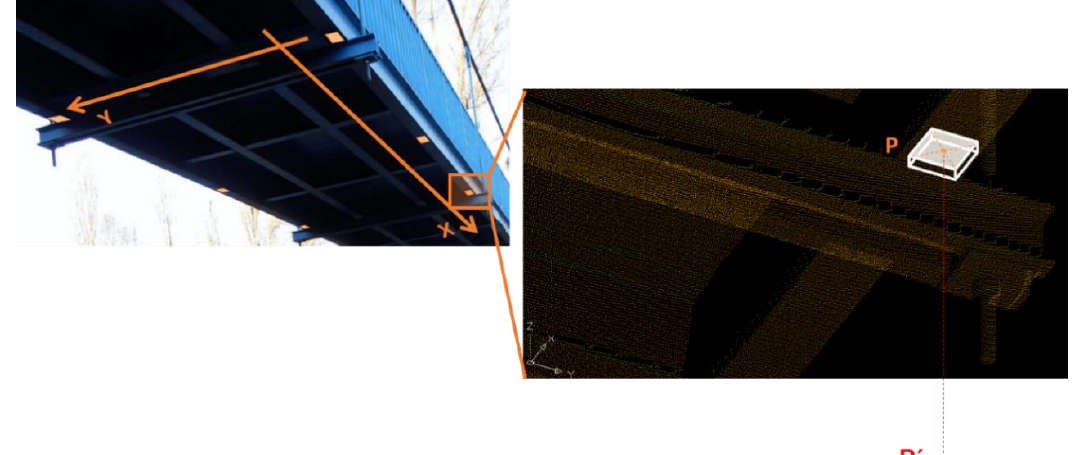
Figure 1. Modelling the height of the monitored point. Definition of a local coordinate system ( left ), pre-segmentation of the point cloud by fencing box and projection of the monitored point onto the modelled regression plane ( right ).